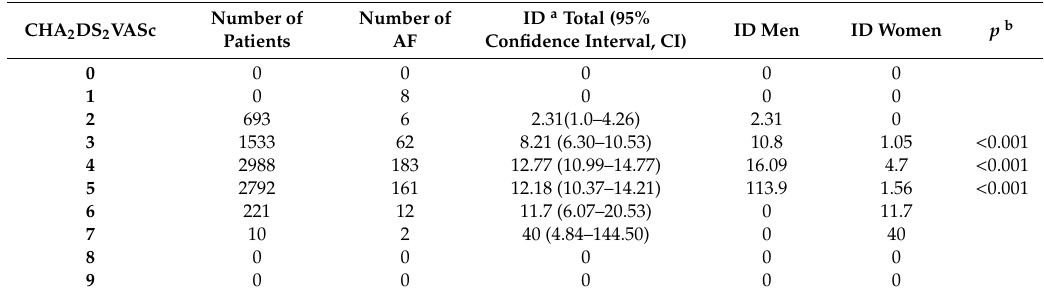
Table 2. AF incidence density according CHA 2 DS 2 VASc score by gender. Number of CHA 2 DS 2 VASc